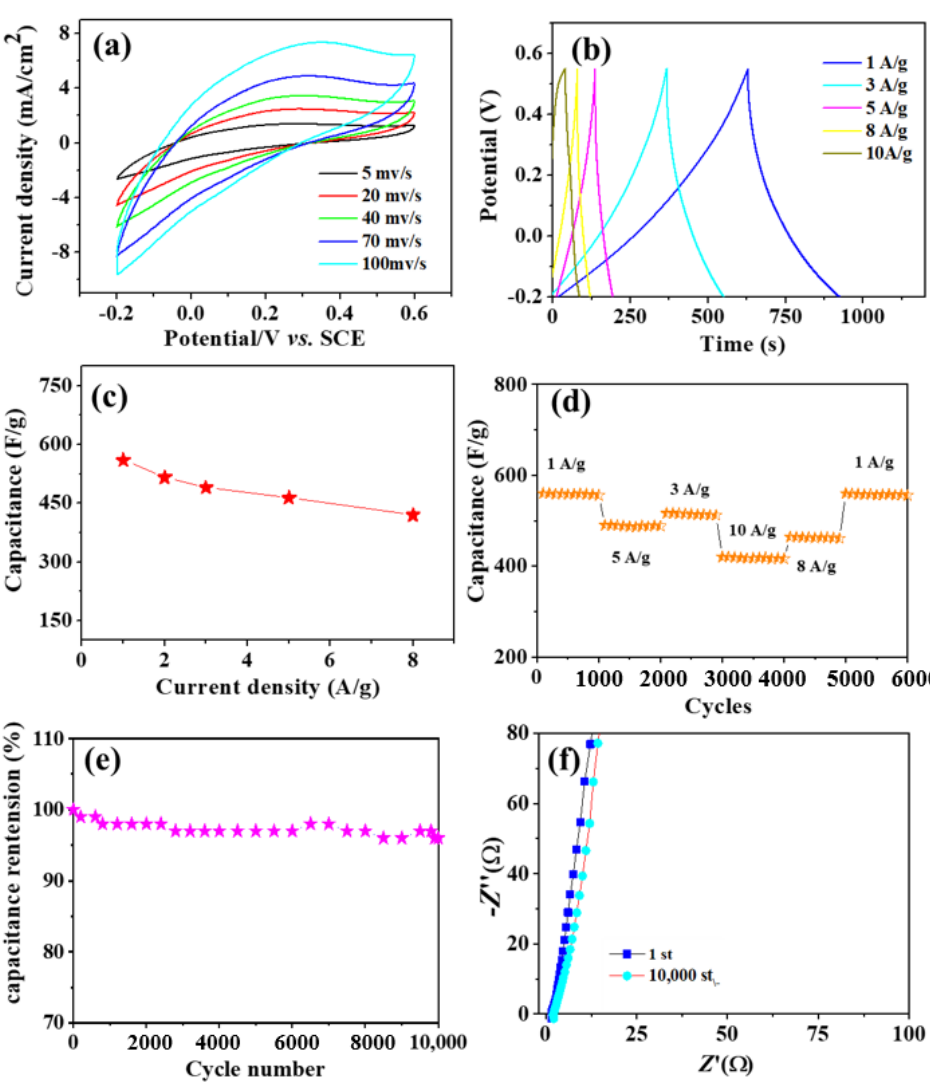
Figure 8. Electrochemical characterization of the WO 3 nanowires film in a three − electrode system. ( a ) CV curves of WO 3 nanowires at a scan rate of 5, 20, 40, 70, and 100 mV/s; ( b ) charge/discharge curves at current densities of 1, 3, 5, 8, and 10 A/g; ( c ) plot of the current density against the specific capacitance of WO 3 nanowires; ( d ) the cycling performance of the WO 3 nanorods tested at different current densities; ( e ) cycling performance at a discharge current density of 2 A/g; ( f ) the electrical conductivity of the product for the first and last 10,000 cycles of the Nyquist